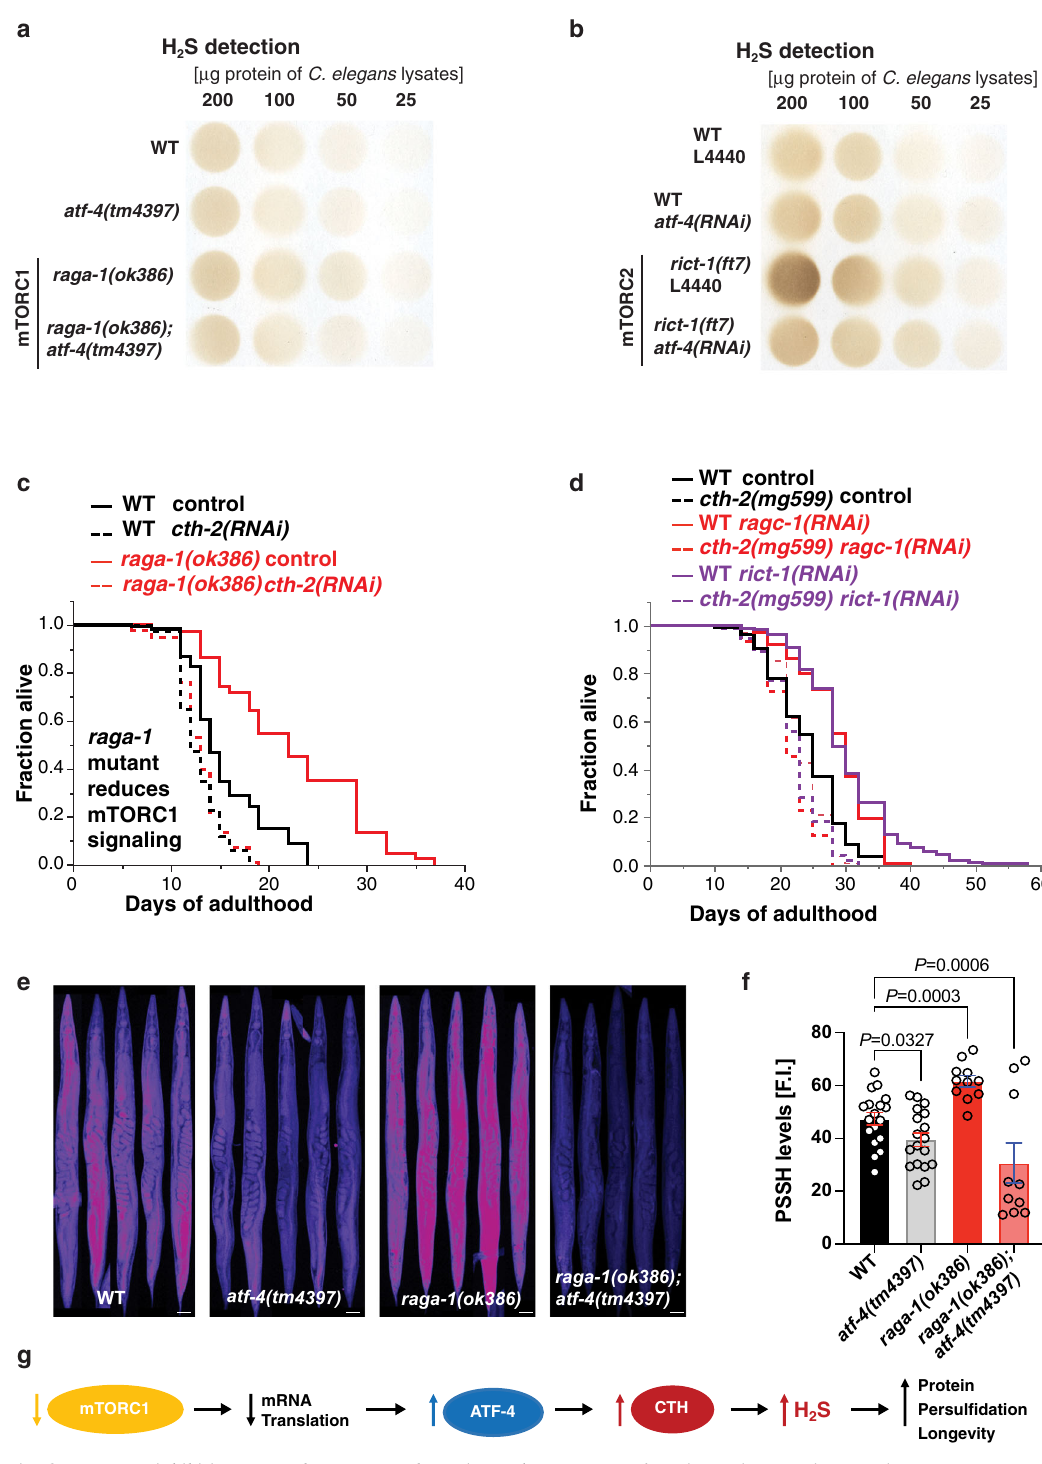
Fig. 7 Longevity from mTOR inhibition upregulates H 2 S and requires cth-2 . a Assay of C. elegans lysates showing that raga-1 mutation increased H 2 S production capacity in an atf-4 -dependent manner. Two additional independent biological trials are shown in Supplementary Fig. 6d. b Assay of C. elegans lysates showing that rict-1 mutation increased H 2 S production capacity in an atf-4 -dependent manner. An additional independent biological trial is in Supplementary Fig. 6e. c Longevity of raga-1(ok386) mutants is ablated by cth-2 knockdown. This particular experiment was performed at 25 °C. d Longevity induced by adult-speci fi c knockdown of either raga-1 or rict-1 depends upon cth-2 . e , f Representative images showing persul fi dation levels in WT (N2), cth-2 (mg599) , atf-4 (tm4397) , raga-1 (ok386) , and raga-1;atf-4 mutants. Data are represented as Mean± SEM. n = 3 biological replicates of at least 10 worms per condition. Scale bar = 50 μ m. P values to WT are unpaired t -test, two-tailed. g Inhibition of mTORC1 promotes longevity by increasing ATF-4 expression and stimulating H 2 S production. For H 2 S quanti fi cation in ( a , b ), see Supplementary Data 12. For statistical details and additional lifespan trials in ( c , d ), see Supplementary Data